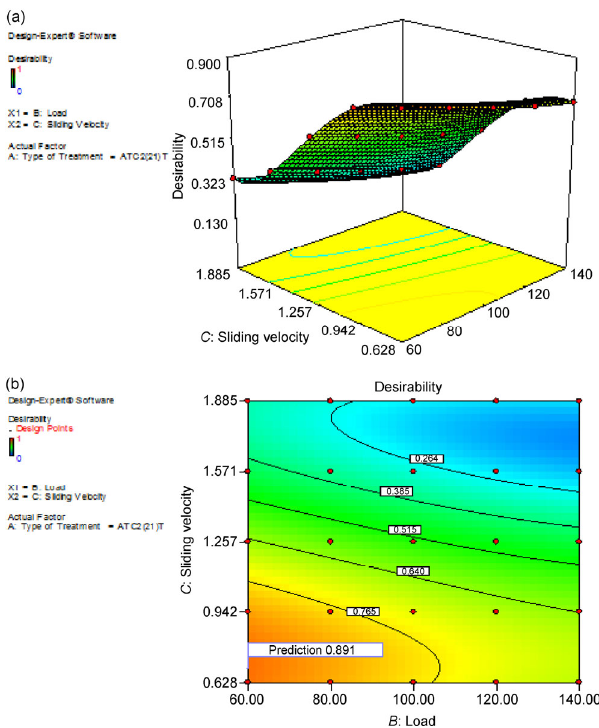
Fig. 20 (a) 3D plot, (b) contour plot for desirability versus sliding velocity and